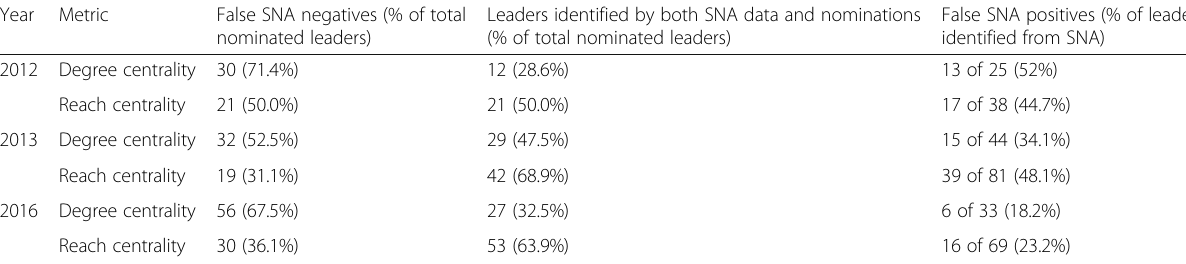
Table 6 Accuracy of leadership identification via degree and reach centralities Year Metric False SNA negatives (% of total Leaders identified by both SNA data and nominations nominated leaders) (% of total nominated